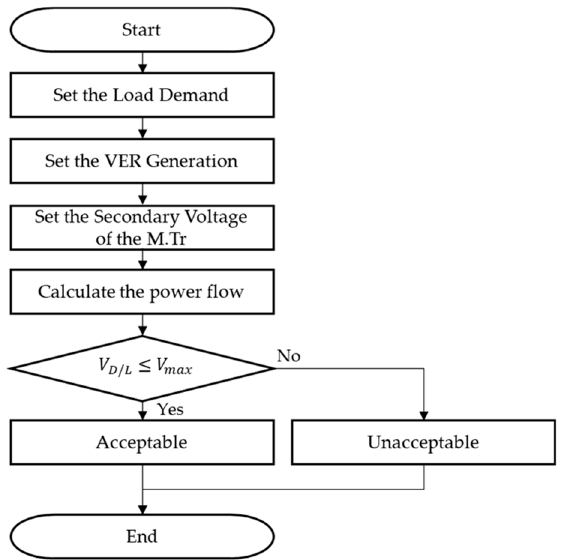
Figure 2. Voltage evaluation for integrating the variable energy resource (VER) into the distribution system.